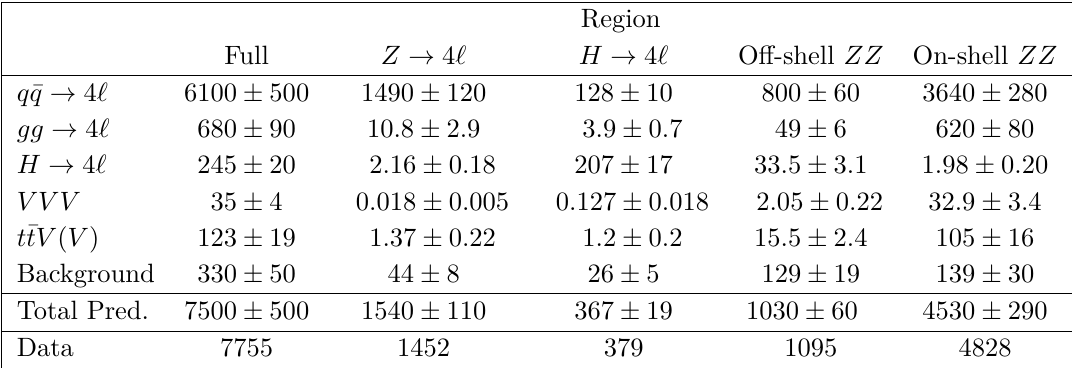
Table 1 . Predicted reconstruction-level yields per process and in total, compared with observed data counts, over the full fiducial phase space and in the following regions of m